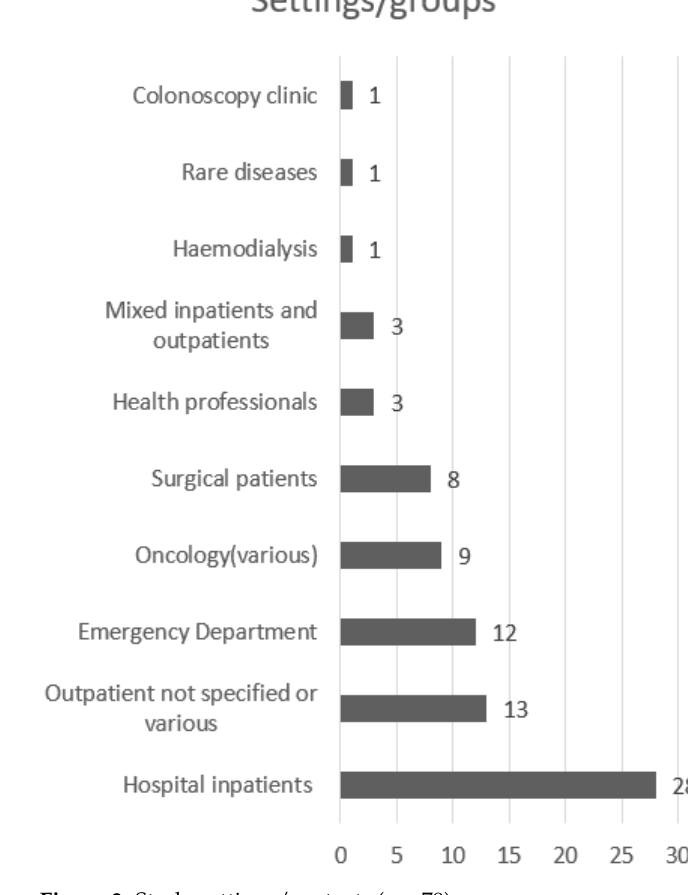
Figure 3. Study settings/contexts ( n = 79).